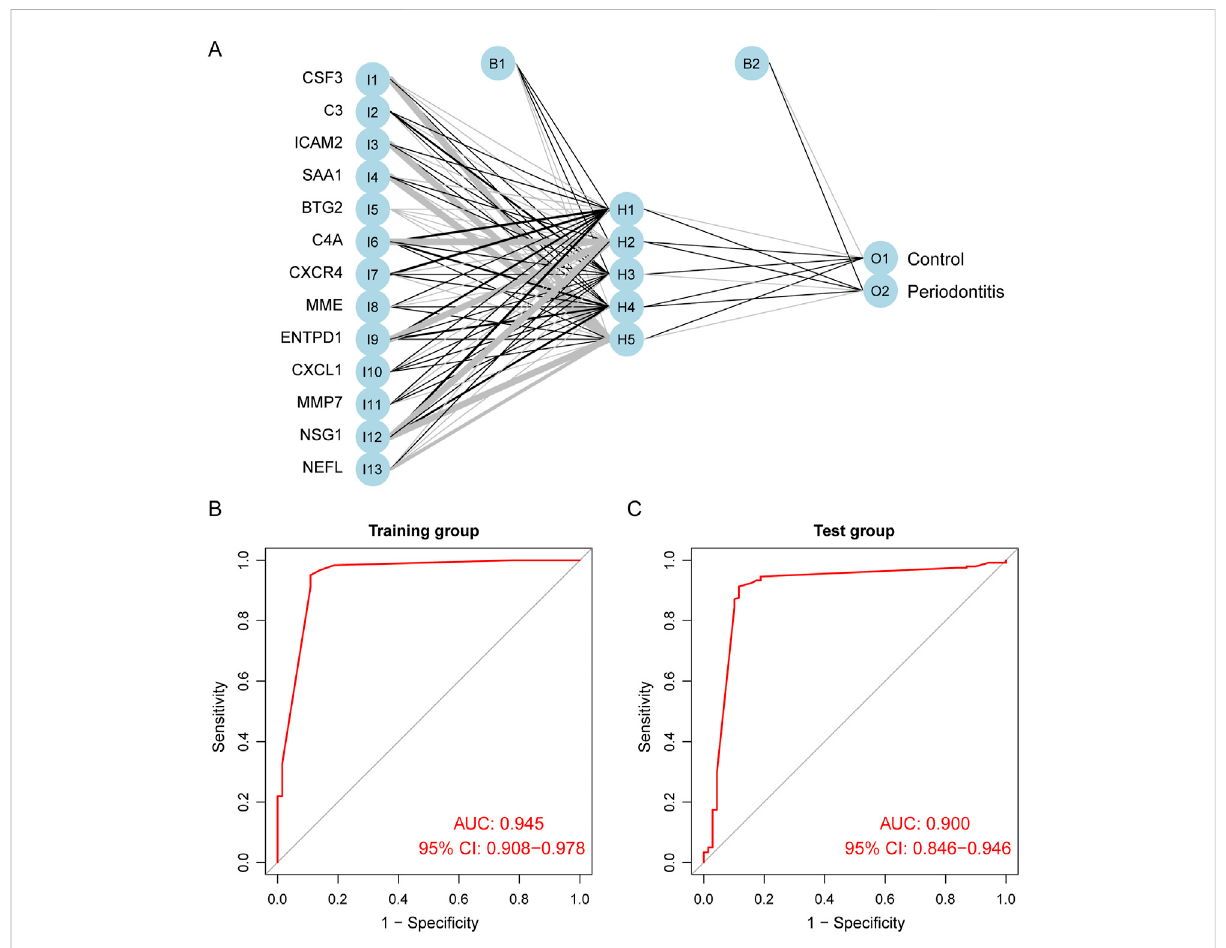
FIGURE 5 Construction and evaluation of ANN diagnostic model. (A) The visualization of the arti fi cial neural network. (B) ROC curves of the training group. (C) ROC curves of the test